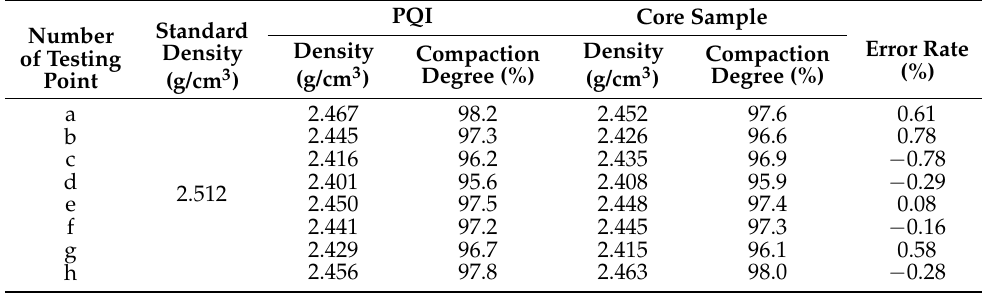
Table 3. Comparison of density values obtained using the PQI method and the core-drilling